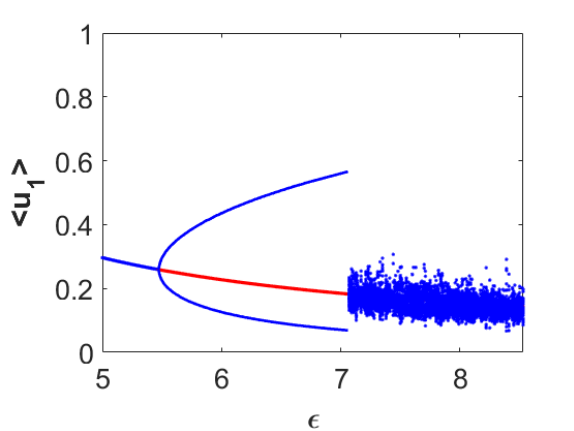
Figure 12. Single parameter bifurcation diagram for the spatially averaged density of first prey population ( < u 1 > ) with respect to the parameter (cid:101) for the spatiotemporal model (11)–(13). Here, backward continuation technique has been employed. Other parameter values are mentioned in (25) with d 3 =